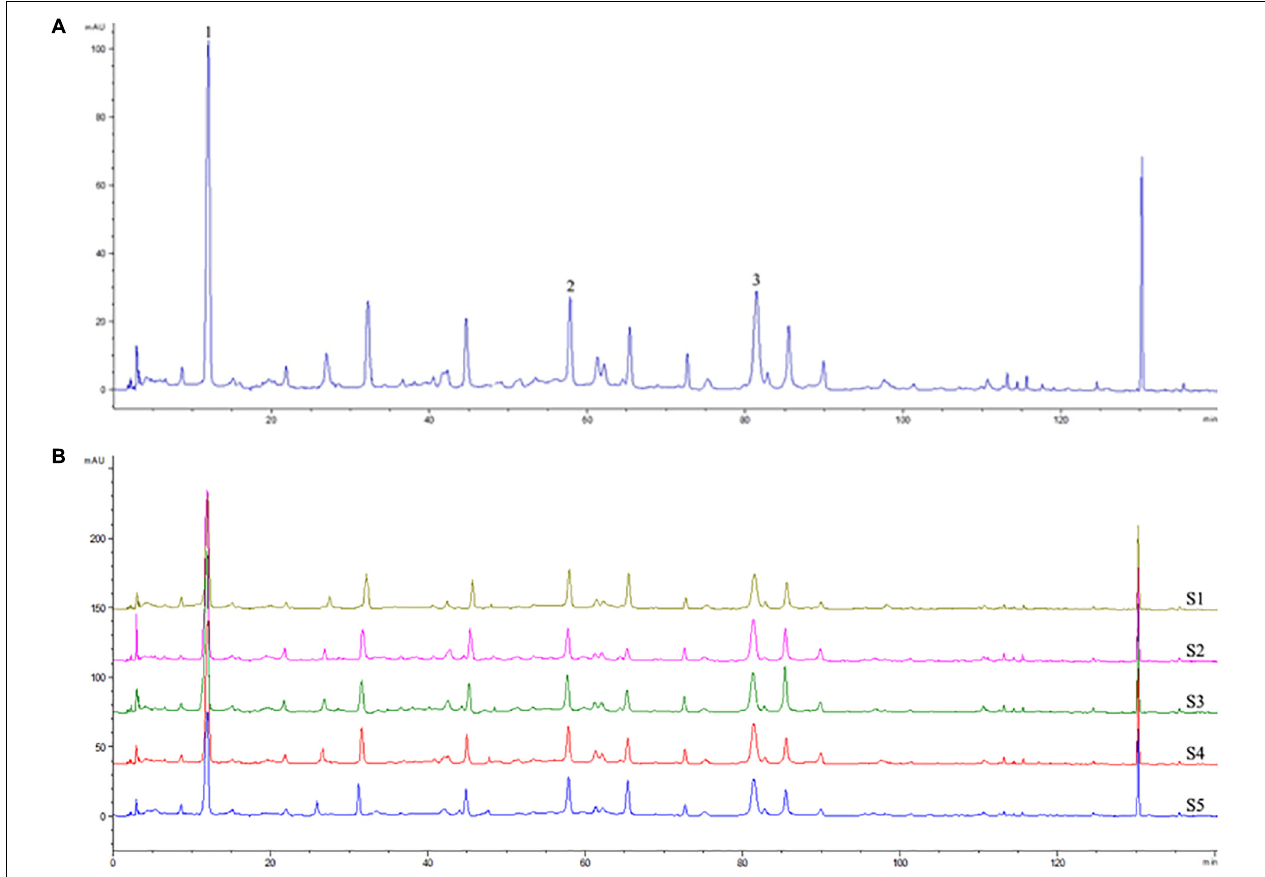
FIGURE 1 | HPLC fingerprint analysis of QP ointment. The HPLC chromatographic of QP at 284 nm wavelength was recorded (A) . There are at least 3 phenotypic peaks, which are derived from gallic acid (1), corilagin (2), and ellagic acid (3), respectively. HPLC fingerprint of 5 batches of QP was also presented (B) .